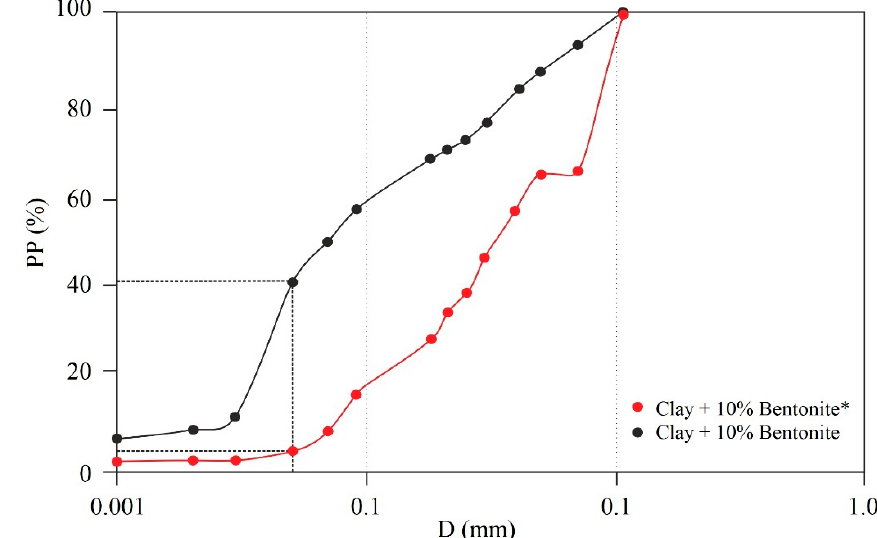
Figure 11. Result of the double hydrometer test on clayey soil with 10% Bentonite (Note: Bentonite* is the value of Bentonite without Sodium hexametaphosphate).